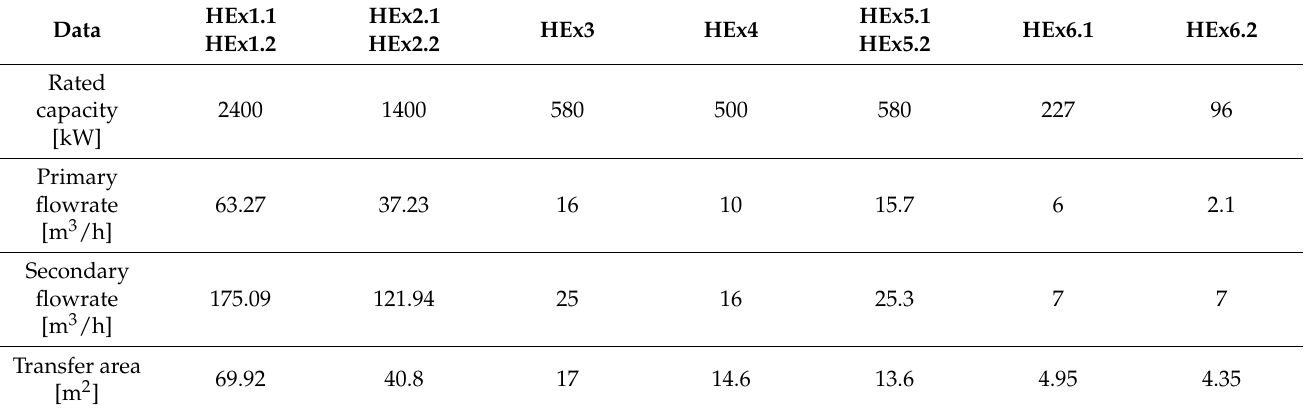
Table 1. Technical data of the plate heat exchangers installed into the UO thermal